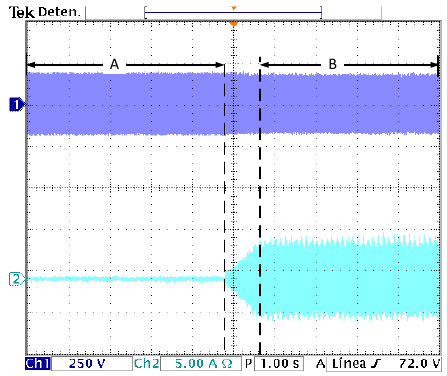
Figure 13. Voltage transition when the system was turned on. A: V N = 130 V RMS and B: V N = 124.6 V RMS . From top to bottom: node voltage and injected